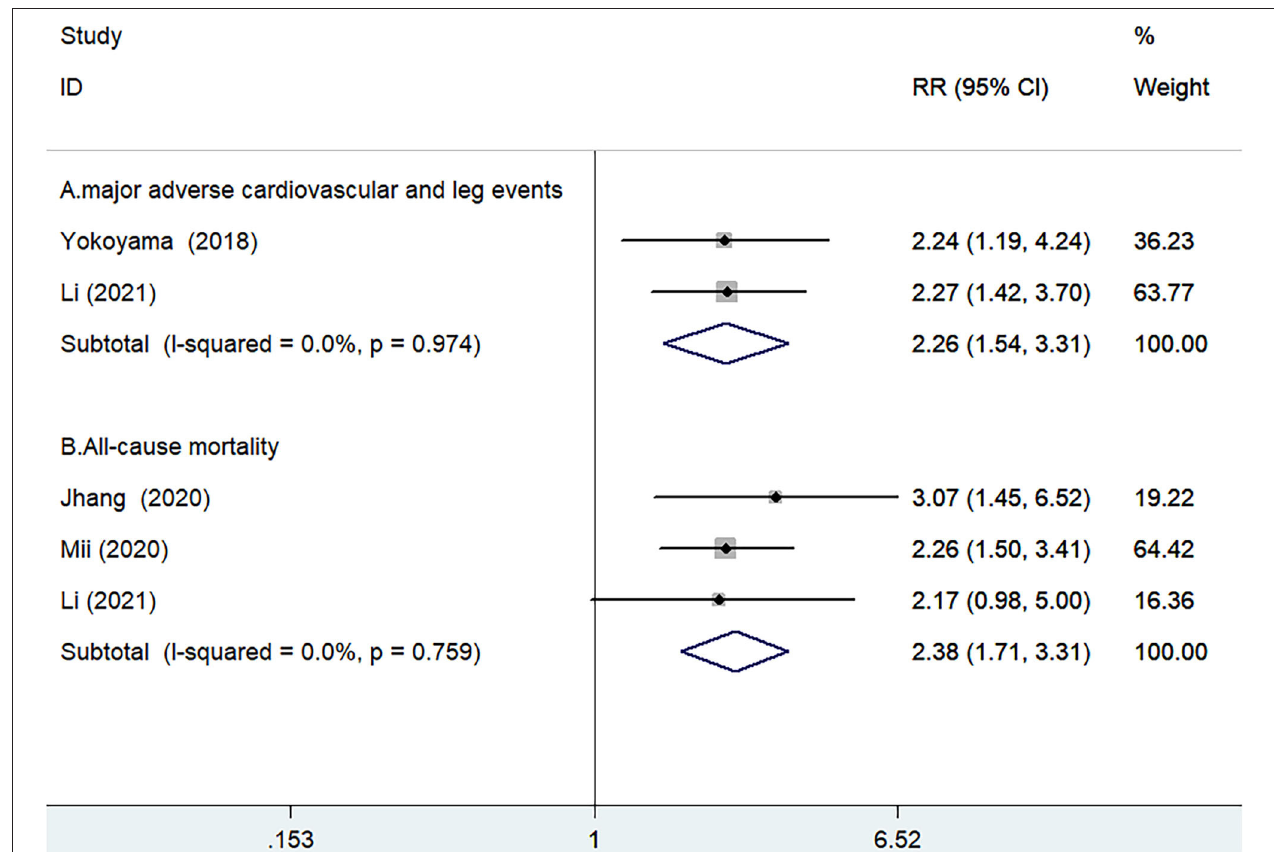
FIGURE 2 | Forest plots showing pooled risk ratio (RR) with 95% CI of MACLEs (A) and all-cause mortality (B) for the low vs . high GNRI